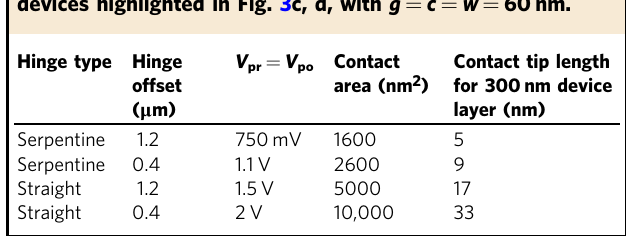
Table 2 Estimated contact area to achieve equal reprogramming and programming voltages ( V po = V pr ) for devices highlighted in Fig. 3c, d, with g = c = w = 60